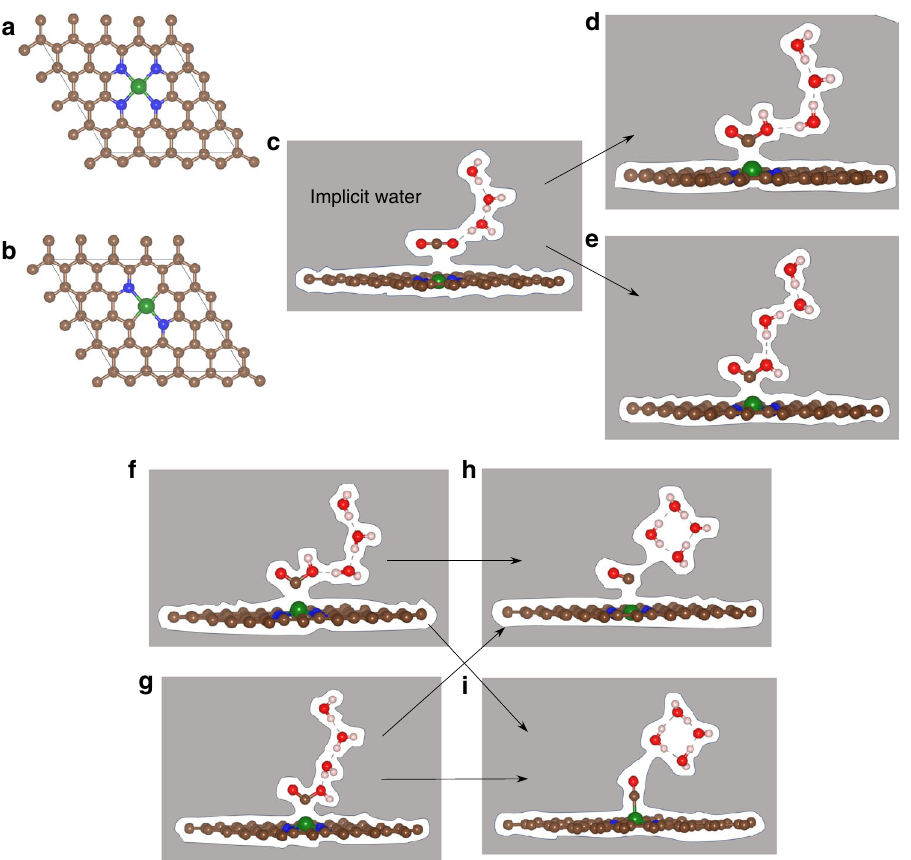
Fig. 1 The CO 2 to CO conversion process on graphene-supported nickel single site. a , b In all, 4 × 4 periodic Ni – SAC system containing Ni – N 4 and Ni – N 2 C 2 moieties as active sites for CO reduction reaction. c The optimized structure of physically adsorbed CO 2 on Ni single site, is stabilized by three molecules of explicit water from solution. d , e The optimized structure of chemically adsorbed cis-COOH (H up) or trans-COOH (H down) respectively. The arrow sign represents the reaction direction where physically adsorbed CO 2 molecule reacts with a neighboring water molecule to produces cis- or trans-COOH intermediates together with hydroxyl ion. The later is stabilized by two explicit water molecules in the solution. f , g Optimized adsorbed cis- and trans-COOH intermediates on Ni – SAC respectively. h , i Optimized structures of CO product binding on Ni – N 4 and Ni – N 2 C 2 site respectively. The arrow sign represents the reaction direction of chemisorbed COOH with water and produce CO and hydroxyl ion in solution. The CO binds on the Ni – N 2 C 2 site perpendicularly representing a stronger attraction than on the Ni – N 4 site. The whole calculation was done by using implicit solvation as in VASPsol and CANDLE solvation as implemented in the VASP and jDFTx code, respectively together with three explicit H 2 O to better describe the charge transfer and polarization. Supplementary Figs. 1 and 2 show that adding additional explicit waters leads to similar results, and supplementary Table 6 shows that reoptimizing the structures with jDFTx leads to negligible changes compared to the optimum structures in VASP. (Gray color to entire surface represents implicit solvation, brown: carbon, blue: nitrogen, green: nickel, red: oxygen, off white: hydrogen associated with the adsorbed species change linearly with U , leading to a smooth reaction pathway along the reaction coordinate. At zero potential, the transformation begins with a charge of 0.4 on the Ni – SACs, which increases to 1.0 as the applied potential is increased to − 0.8 V. To show the linear relationship between applied potential and charges on the species more quantitatively, we compare this reaction path for the GCP- K model with the conventional Butler – Volmer PCET kinetics in Fig. 5. This shows that at potential U 0 , the transition state, TS 0 (Fig. 5a) corresponds to the spatial geometry R 0 but as the applied potential changes to U 1 the transition state (TS 1 ) moves leftward toward reactant reaching to R 1 (refs. 47,48 ). In this grand canonical potential kinetics (GCP-K) description, the fractional charges change continuously along the reaction coordinates as the applied potential is changed, as shown in Fig. 5b, c. Initially, at zero voltage the reaction barrier is 16.89 kcal mol − 1 , the TS has a slightly negative charge (0.4 e ) and the OC – OH distance is about 2.77 Å, very similar to the product (Fig. 4c). But as the applied potential is changed to − 0.8 V, the barrier decreases continuously